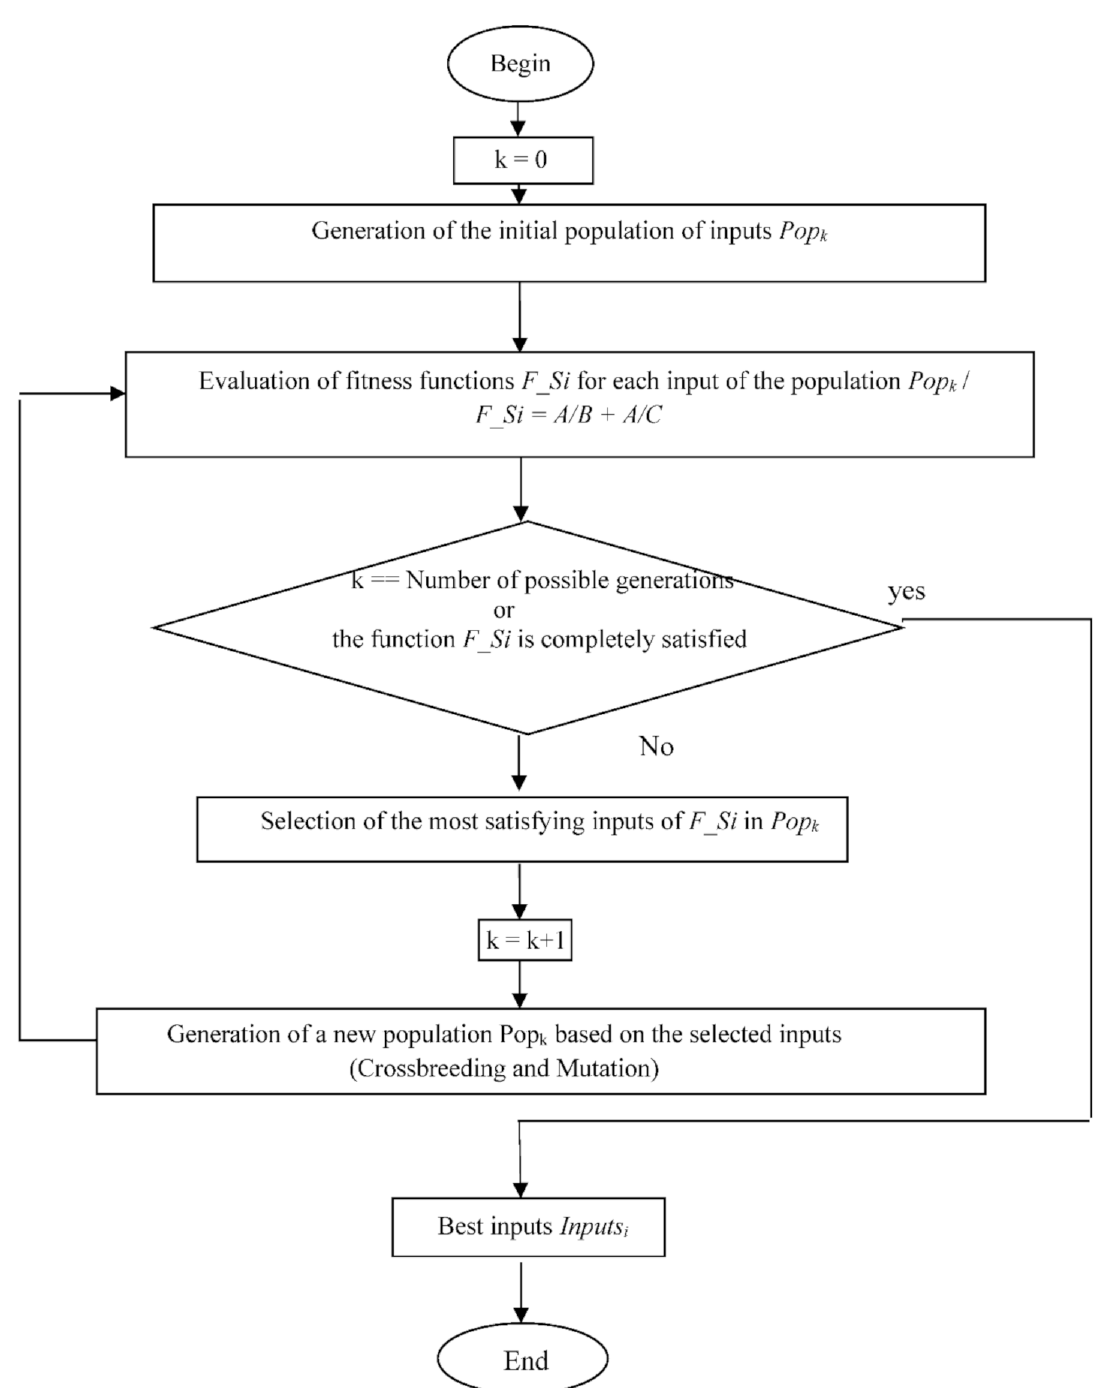
Figure 2. Test case inputs generation